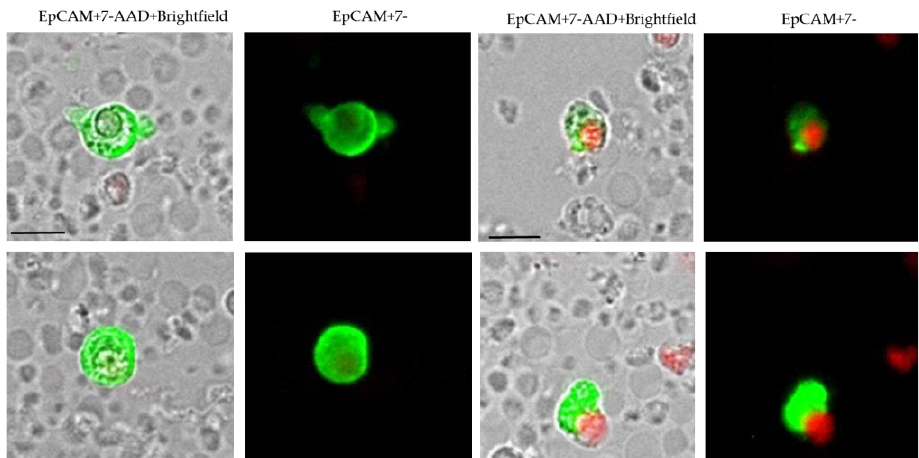
Figure 1. Circulating epithelial tumor cells. Viable (the four micrographs on the left) and apoptotic (the four micrographs on the right) EpCAM-positive (green) cells. In viable cells the cell membrane is impermeable preventing the nuclear dye 7-AAD (red) from entering the cell. In apoptotic cells the cell membrane becomes permeable allowing the nucleus to be stained with 7-AAD.